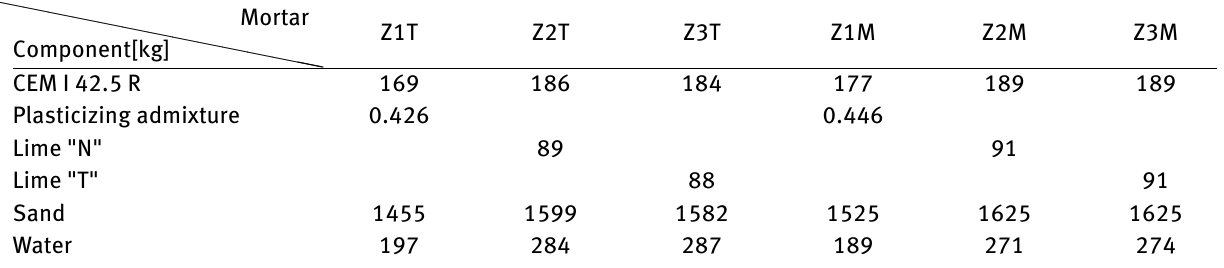
Table 1: Compositions of the plaster mortars for 1m 3 . (cid:96)(cid:96)(cid:96)(cid:96)(cid:96)(cid:96)(cid:96)(cid:96)(cid:96)(cid:96)(cid:96)(cid:96)(cid:96)(cid:96)